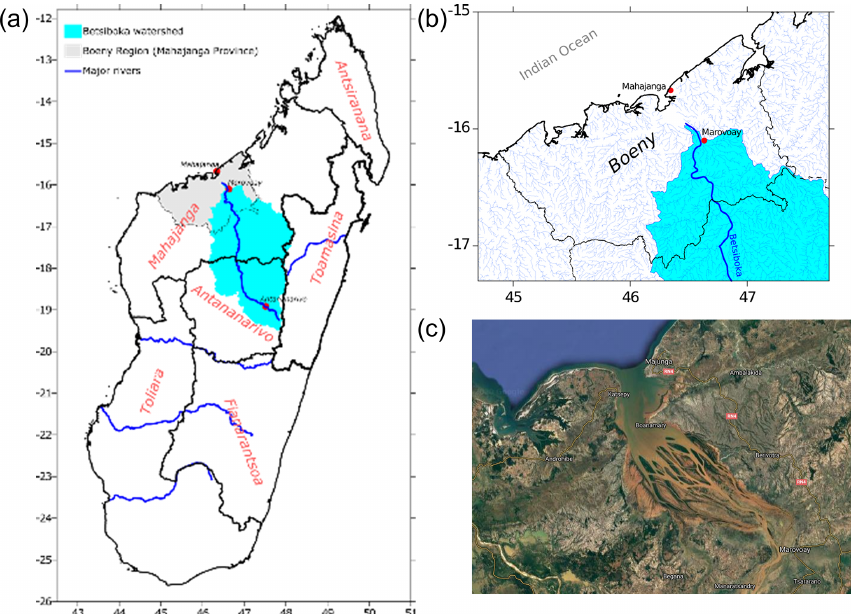
Figure 1. (a) Location of the Betsiboka river catchment area (in blue) and the Boeny region (in grey). (b) Zoom on the Boeny region and the regional hydrographic network (data from HydroRIVERS 1.0 database). (c) Zoom on the Betsiboka River delta and Bombetoka Bay (TerraMetric image 2020, from © Google